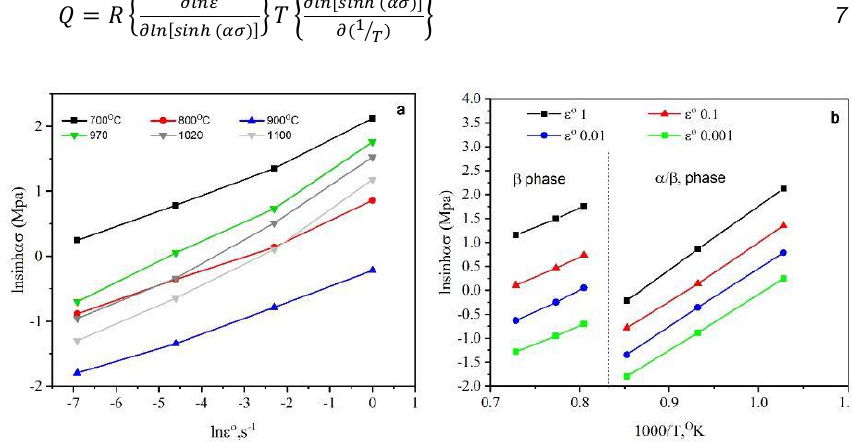
Fig. 6. Plot of lnsinh (ασ)-lnε˚-nhlnsinh